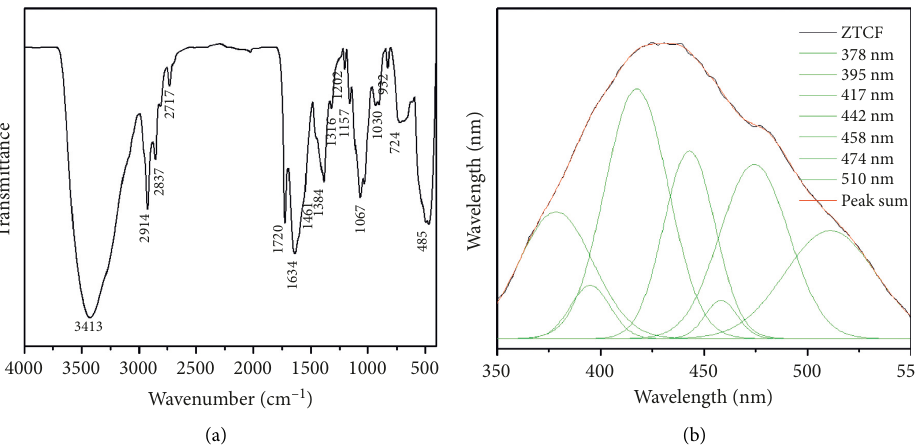
2 -chitosan-farnesol